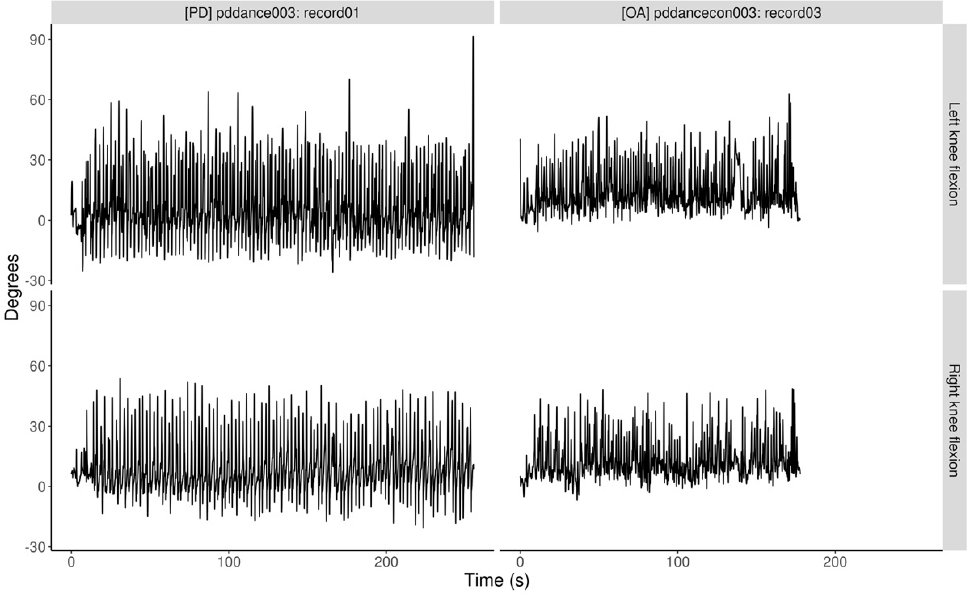
Figure 2. Tango: left and right knee flexion over time. PD ( left ) and OA ( right ) recordings of left and right knee flexion during one session of tango for one PD and one OA participant, no filtering or down sampling was performed.